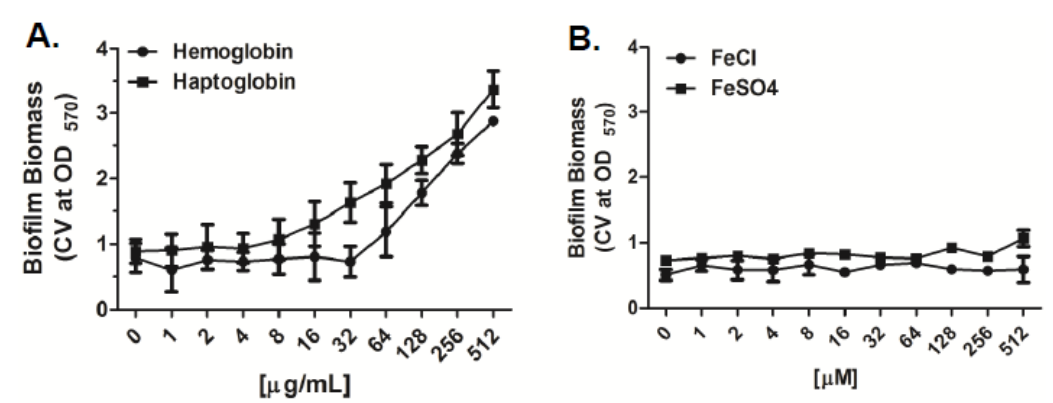
Figure A1. Effect of heme iron and non-heme iron sources on biofilm formation in vitro. A. baumannii strain 17978, was grown for up to 24 h in MHB II (0.3 g/L) supplemented with increasing concentrations of ( A ) human hemoglobin or haptoglobin (0–512 µg/mL) or ( B ) FeCl 3 , or Fe 2 (SO 4 ) 2 (0 to 50 µM). Biofilm biomass, is reported as the measured absorbance of solubilized crystal violet of stained biofilms at 570 nm (CV at OD 570 ), Values represent the mean ± SEM of three independent experiments.